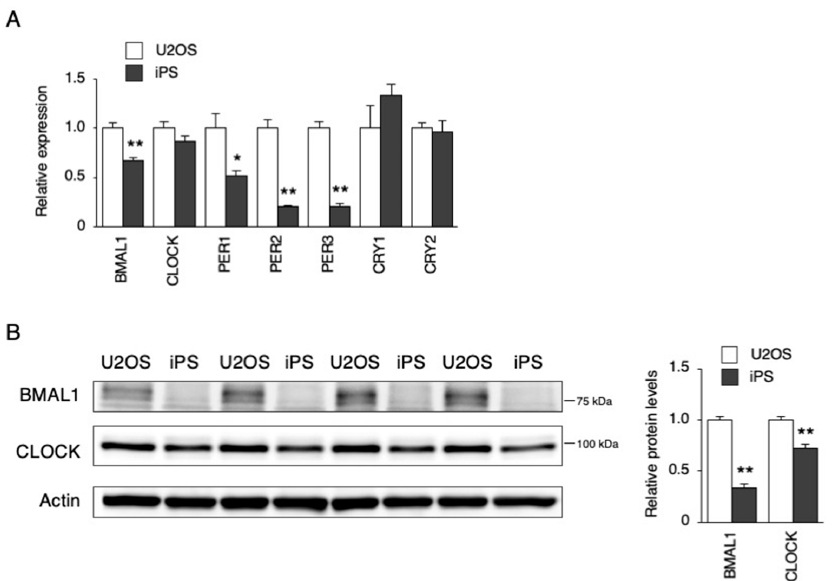
Figure 5. Expression levels of the clock genes in hiPSCs. ( A ) The expression levels of clock genes in U2OS cells and hiPSCs. Data are presented as the means ± SEM relative to U2OS; n = 4 for each comparison. * p < 0.05, ** p < 0.01 versus the corresponding control. ( B ) BMAL1 and CLOCK protein levels in U2OS cells and hiPSCs. Left, representative blot images. Right, the quantification of their blots. Data are presented as the means ± SEM relative to U2OS. n = 4 for each comparison. ** p < 0.01 versus the corresponding control.